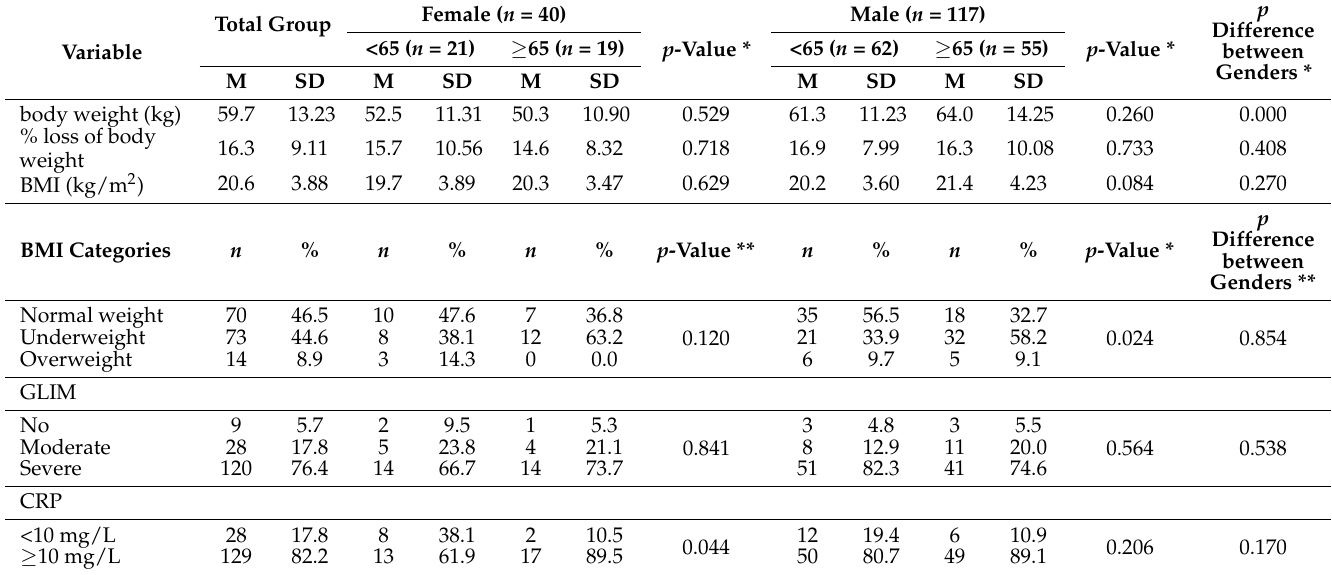
Table 1. Characteristics of the study group divided by sex and